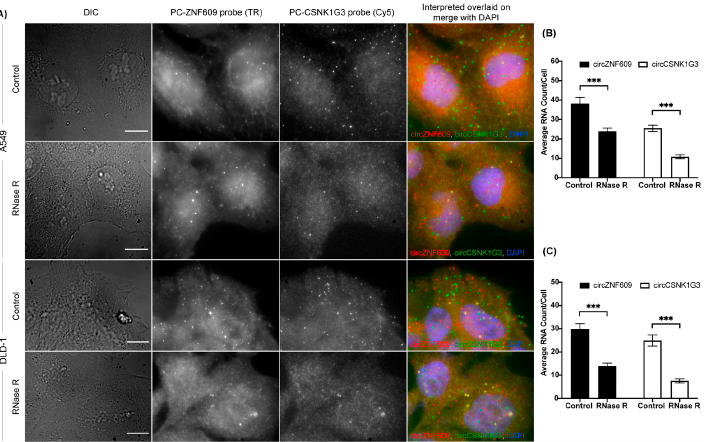
Figure 4. Multiplexing circFISH for the simultaneous visualization of multiple circRNAs using in- situ RNase R treatment. ( A ) A representative image panel of A549 and DLD-1 cells with no (labeled as Control) or 4 h of RNase R treatment (labeled as RNase R), with PC probes of ZNF609 and CSNK1G3. Columns from the left: DIC; raw merged z stacks of cells for the PC ZNF609 probes labeled with TR; raw merged z stacks of cells for the PC CSNK1G3 probes labeled with Cy5; and a merged image of the two channels with the TR spots colored red and Cy5 colored green, overlaid on DAPI with MATLAB-interpreted spots showing circZNF609 as red and circCSNK1G3 as green. ( B , C ) Quantification of circZNF609 and circCSNK1G3 signals in the control, and RNase R-treated A549 and DLD -1 cells, respectively. The error bars indicate the 95% confidence interval for at least 100 cells. *** Indicates a significant difference with a p -value < 0.001. The scale bar is 5 μ m.